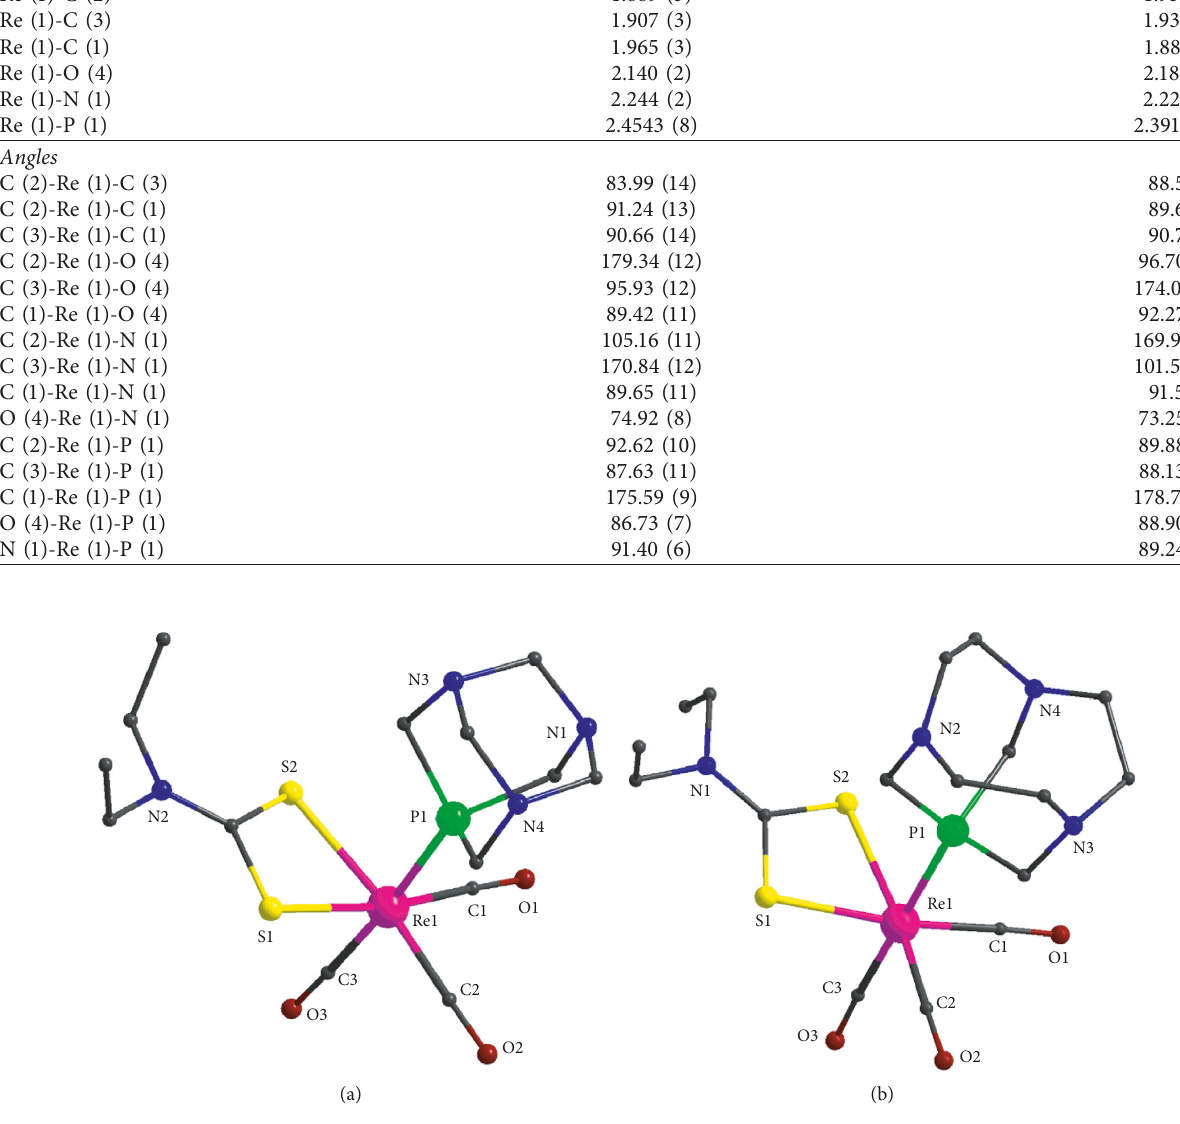
Figure 2: Partially labelled plots of 3a (a) and 3b